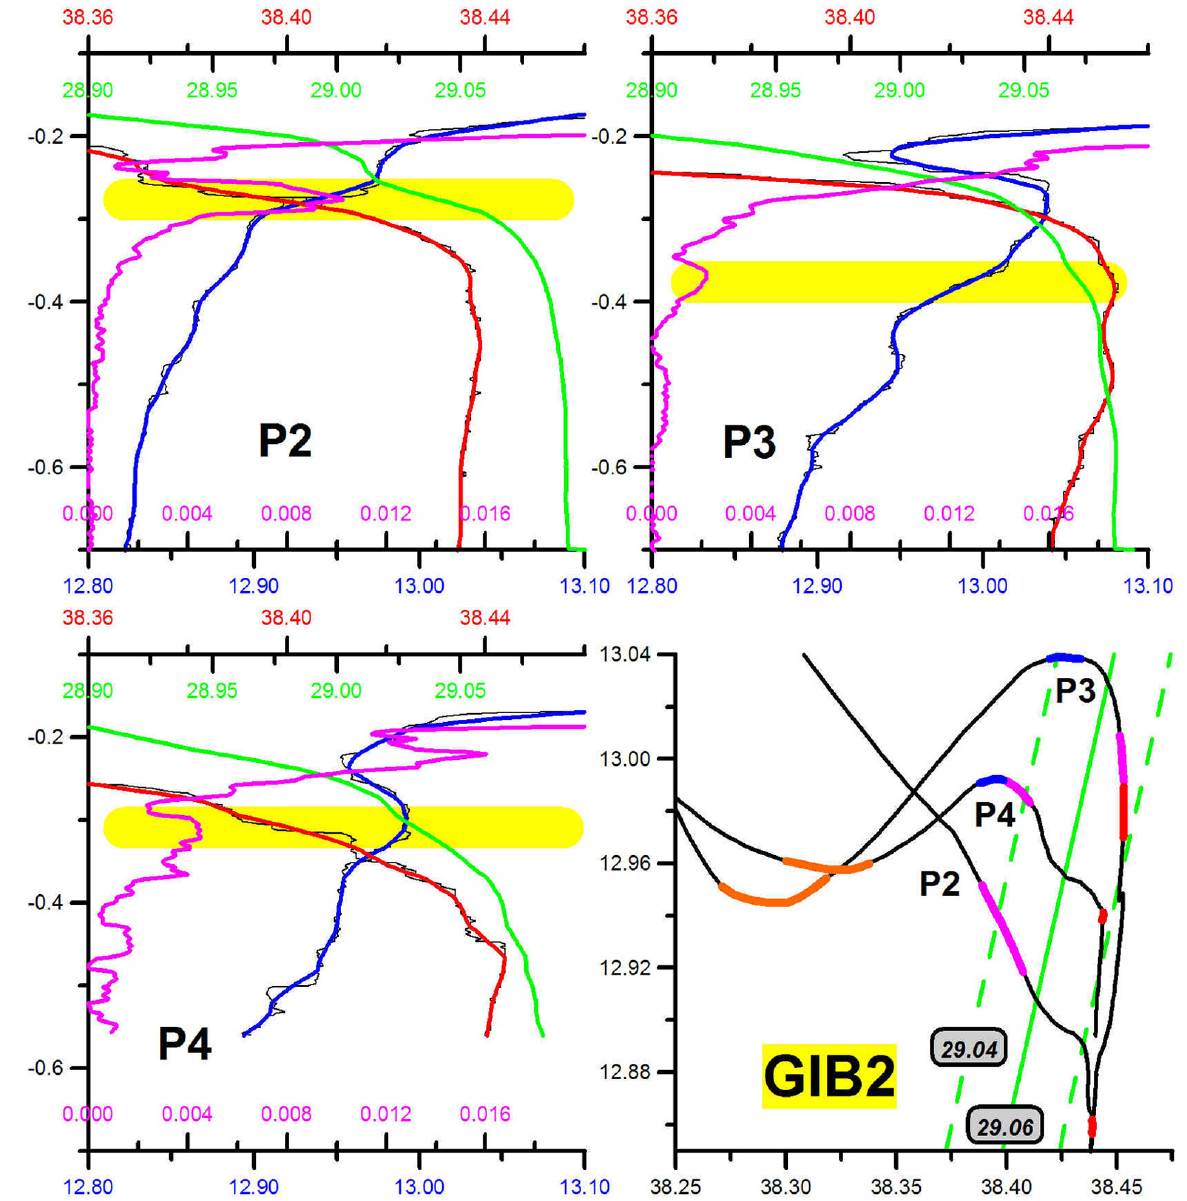
Fig. 5. – As Figure 4 for GIB2 except for the q axis of the q -S